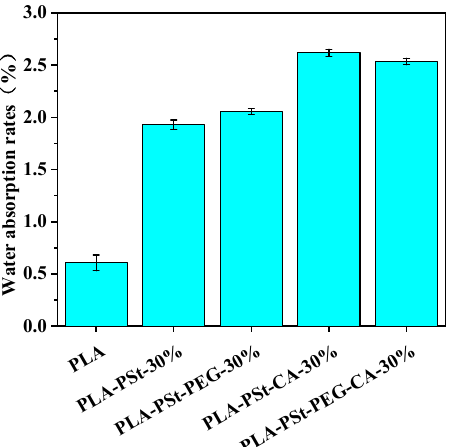
Figure 7. Water absorption rates of pure PLA and PLA/PSt, PLA/PSt/PEG, PLA/PSt/CA, and PLA/PSt/PEG/CA blends.